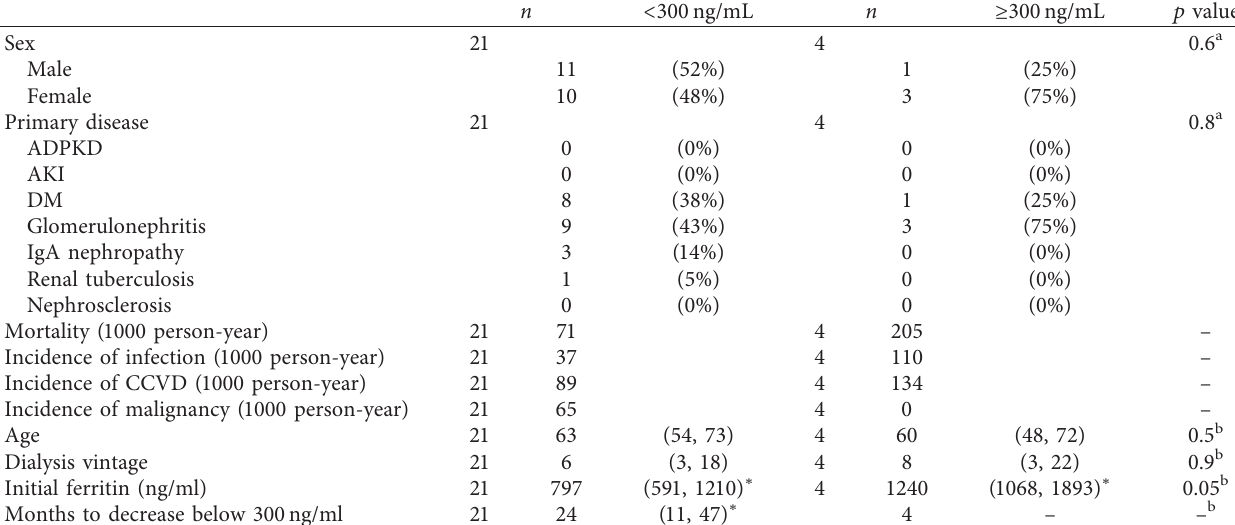
Table 2: Comparison of patients with initial ferritin levels > 500ng/mL categorized by ferritin levels at the end of the 10-year follow-up period.